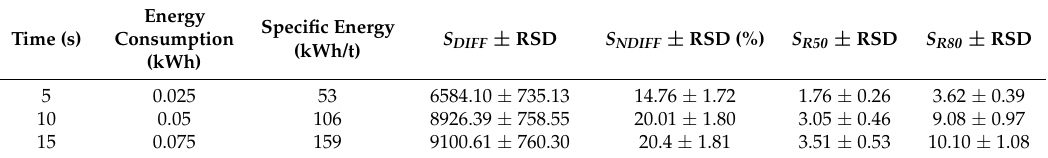
Figure 15. Comparison of S NDIFF factor for wet grinding with 10/1 rods and 1600 kg/m 3 density. Table 4. Comparison of grinding effectiveness factors for wet grinding with 10/1 rods and 1600 kg/m 3